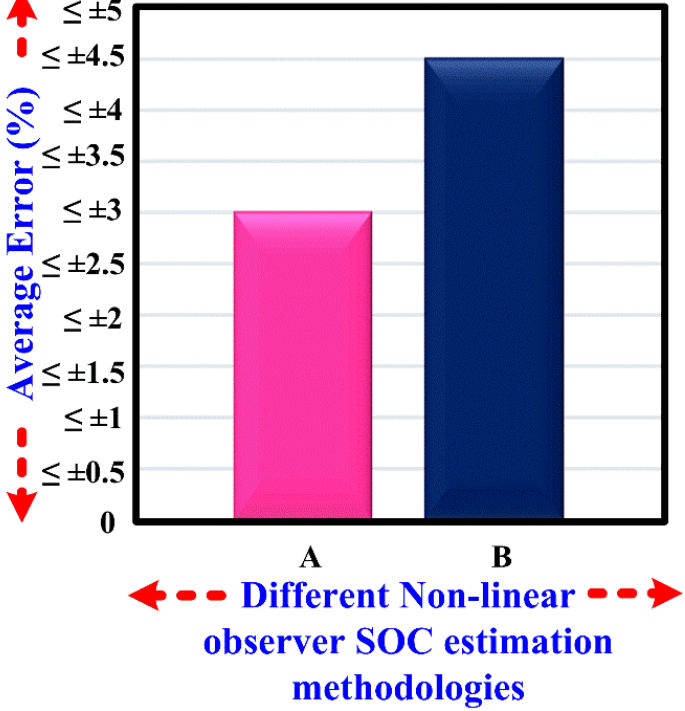
Figure 13. Comparison between the different nonlinear observer SOC estimation methods. “A” is referred to as [110], and “B” is referred to as [131].